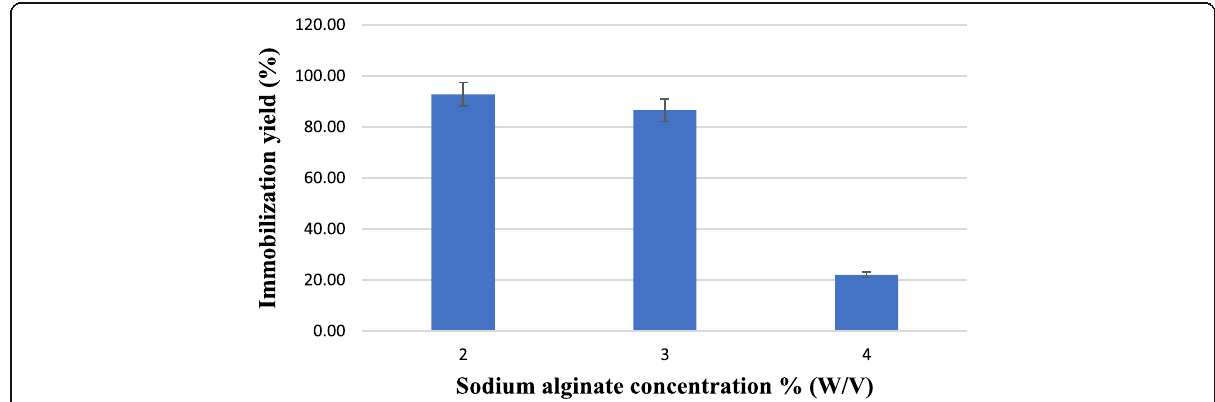
Fig. 5 Effect of concentration of sodium alginate on amylase immobilization